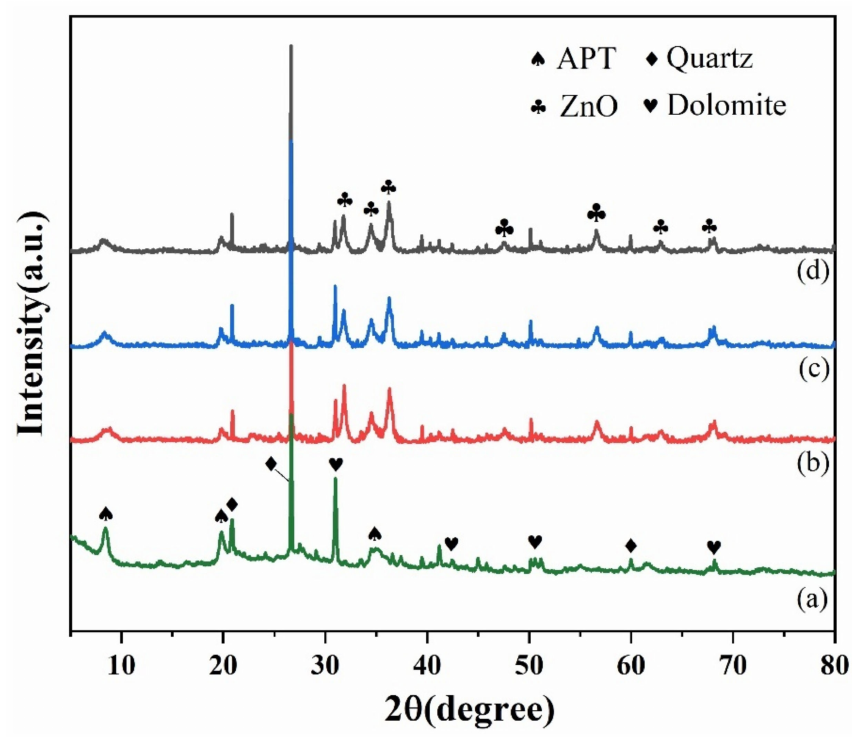
Figure 2. XRD patterns of ( a ) APT, ( b ) ZnO/APT, ( c ) C–ZnO/APT-2.5% and ( d ) MAG/C–ZnO/APT-2.5%.